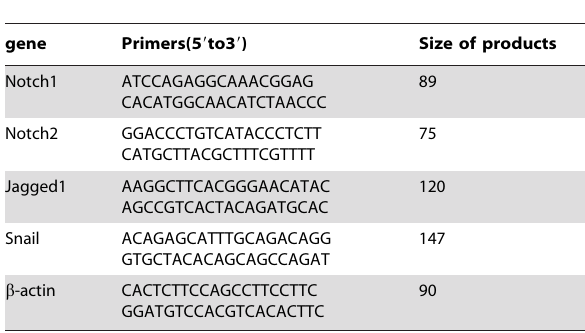
Table 1. qPCR primers and products for notch